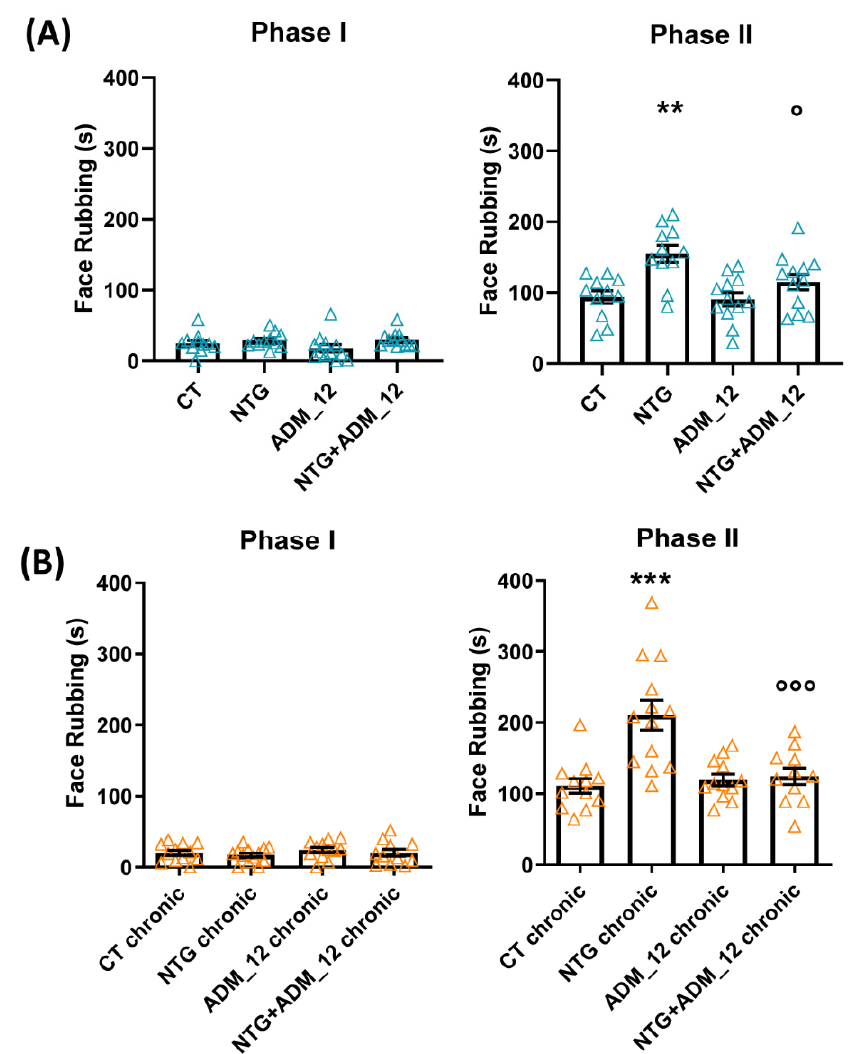
Figure 1. Effects of ADM_12 (30 mg/kg) in the orofacial formalin test. Face rubbing time (seconds) during Phase I and II of the orofacial formalin test in the acute migraine model ( A ) and in the chronic migraine model ( B ). CT: Control. Data are expressed as the mean ± SEM. One-way ANOVA followed by Tukey’s multiple comparisons test ( n = 11–13 per group). ** p < 0.01 vs. CT and ADM_12;